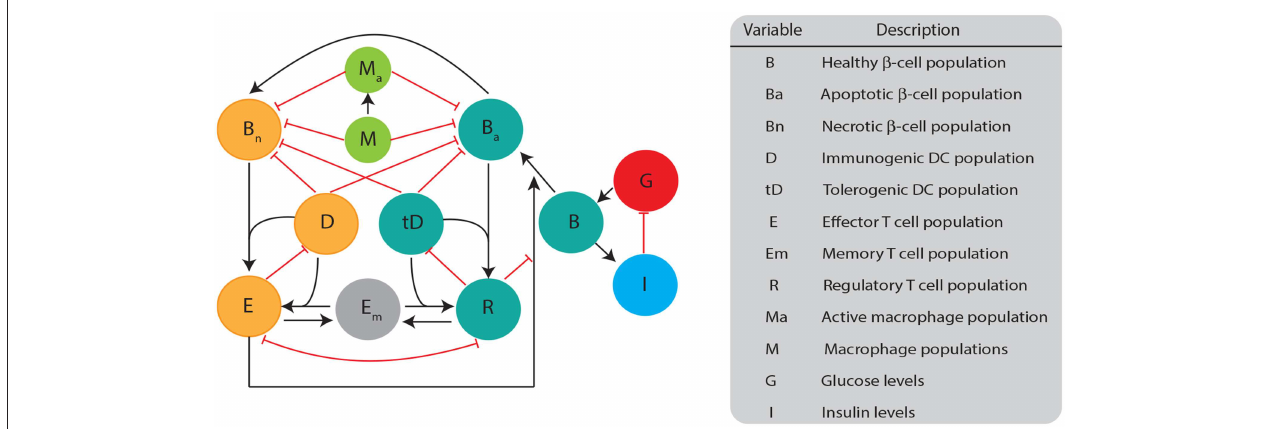
FIGURE 1 | Diagram illustrating the biological quantities and interactions that are tracked in our single compartment model. β -cell populations are split into three categories: healthy population ( B ), apoptotic cells ( B a ), and necrotic cells ( B n ). Healthy β -cells are involved in glucose ( G ) and insulin ( I ) regulation, whereas the dying β -cells (apoptotic and necrotic) interact with immune cells. Dendritic cells are split into two categories: immunogenic DC ( D ) and tolerogenic DC ( tD ) based on their ability to engage an immunogenic or tolerogenic T cell response. DCs in our model are assigned into a particular category once they engulf either apoptotic or necrotic β -cells. Macrophages can either be in an activated ( M a ) or non activated form ( M ) based on their capacity to engulf β -cells. T cells are split into: regulatory T ( R ), effector T ( E ), or memory T ( Em ). All populations are measured in cells ml − 1 except for B (mg), G (mg dl − 1 ), and I ( µ